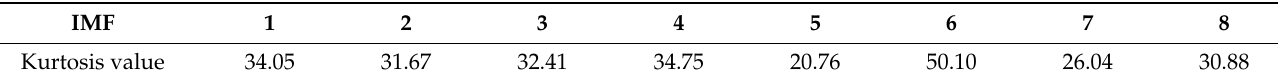
Table 4. Kurtosis values of IMFs for experimental signals.